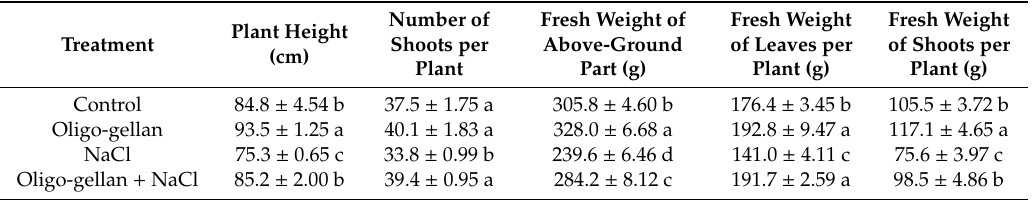
Table 1. E ff ects of oligo-gellan pretreatment (100 ppm) and salt stress (100 mM NaCl) on red perilla growth parameters. Mean values in the columns marked with the same letters show no significant di ff erence at p ≤ 0.05 (Tukey’s test, n = 9).